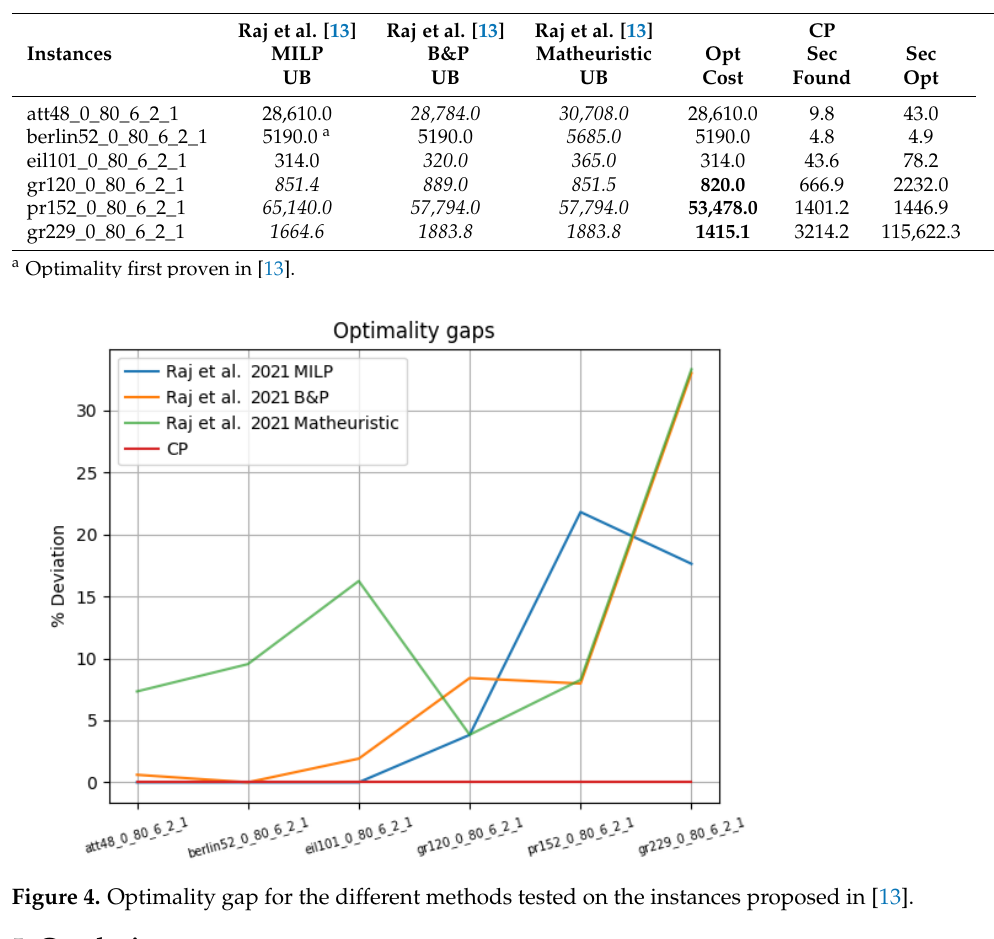
Table 8. Instances originated from TSPLIB in [13]. Optimal solution costs.